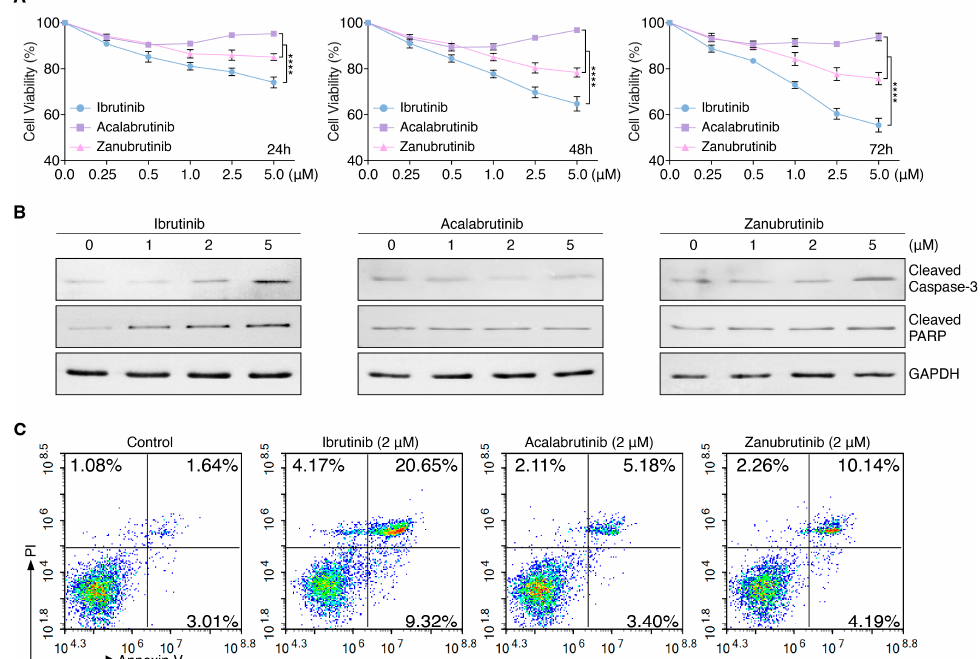
Figure 1. BTKis induce caspase-dependent apoptosis in HUVECs. ( A ) BTKis reduce cell-viability of HUVECs. Endothelial cells were treated with Ibrutinib, Acalabrutinib or Zanubrutinib in a dose- dependent manner for 24, 48 and 72 h ( n = 6). The cell-viability was determined by AlamarBlue assay. Data are shown as mean ± SEM; **** p < 0.0001, as calculated using two-way ANOVA with Tukey’s multiple comparisons test. ( B ) The levels of cleaved caspase-3 and cleaved PARP were increased in endothelial cells treated with Ibrutinib or Zanubrutinib, and remained constant after treatment with Acalabrutinib in a dose-dependent manner for 24 h, which were examined by immunoblot analysis. ( C ) Flow cytometry analysis of apoptosis induced by Ibrutinib, Acalabrutinib or Zanubrutinib at 48 h in HUVECs stained with Annexin V-FITC and PI, and analyzed by NovoExpress software. The percentages in the top right and bottom right of each pseudocolor plot indicate the proportion of Annexin V/PI-positive apoptotic cells.